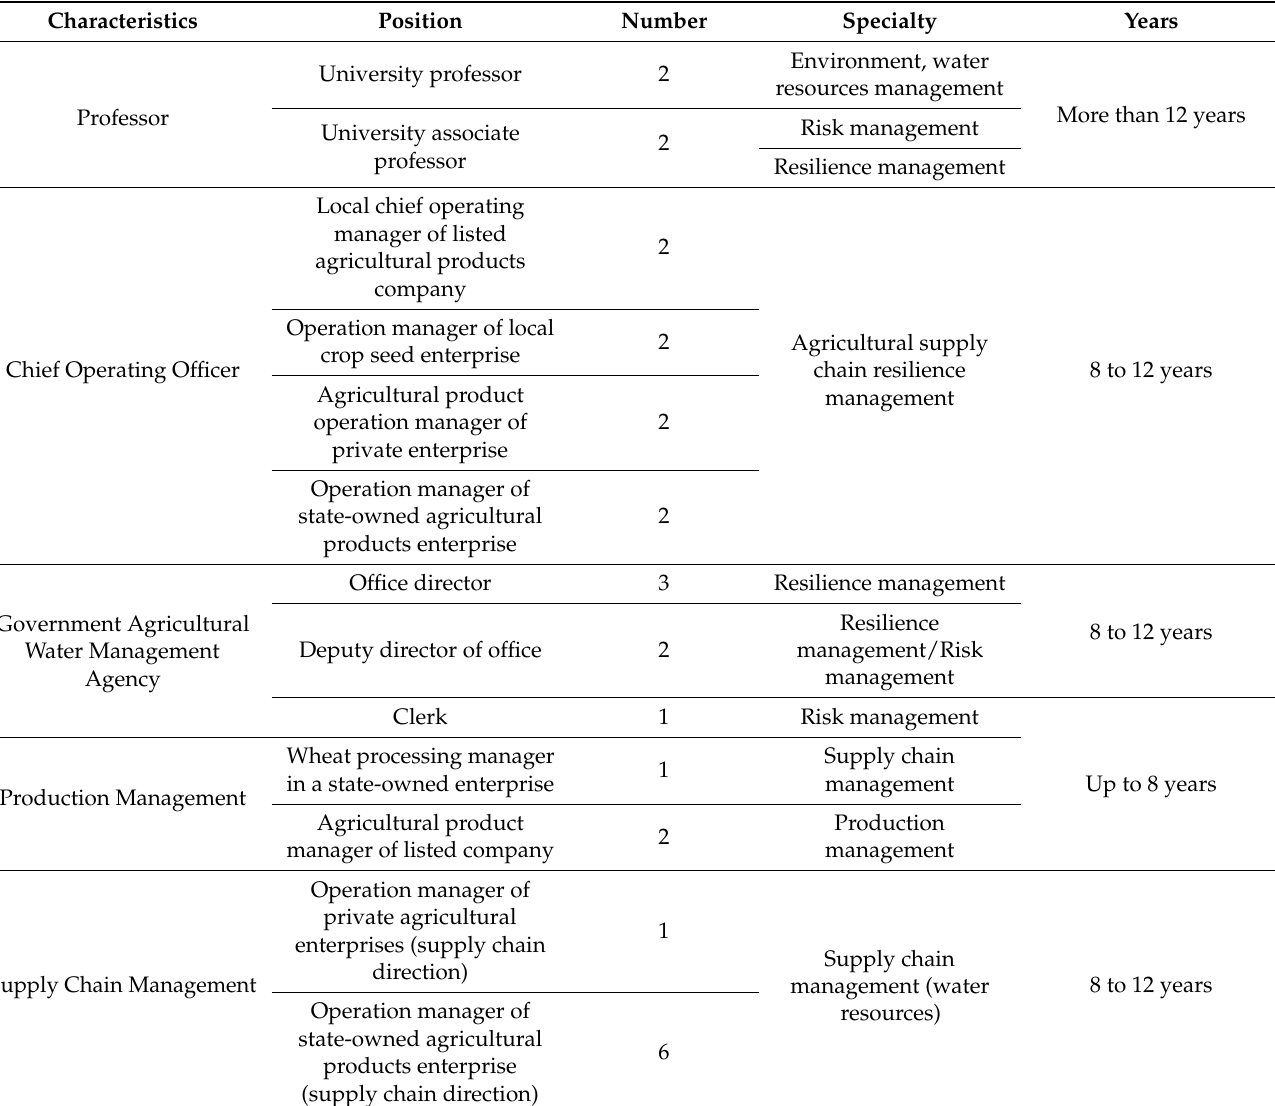
Table 2. Brief description of profiles of the